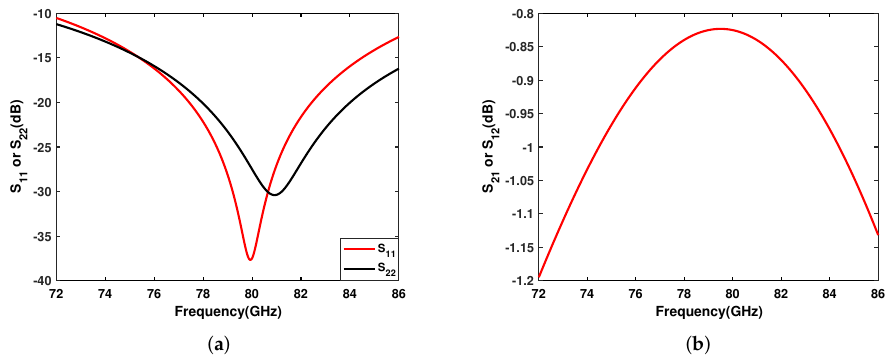
Figure 5. Simulation results of the package-board transition. ( a ) S 11 or S 22 , ( b ) S 21 or S 12